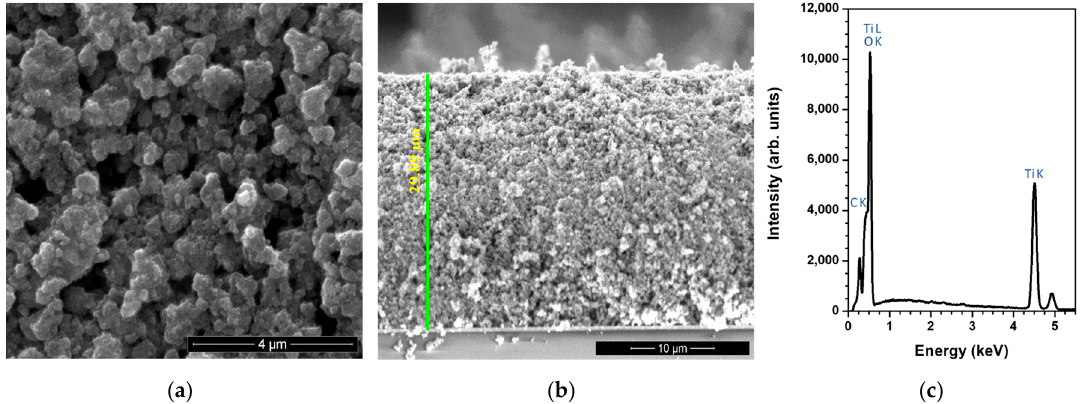
Figure 2. SEM micrographs, top-view ( a ) and cross-section showing a thickness of 29.89 µm ( b ), and energy dispersive spectroscopy (EDS) spectrum ( c ) of the TiO 2 mesoporous layer.